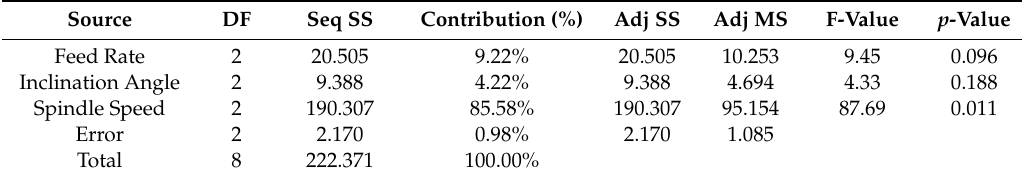
Table 9. Results of the ANOVA for Power.